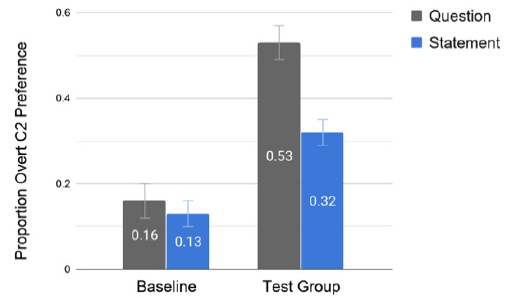
Figure 3. Proportion overt C2 preference.